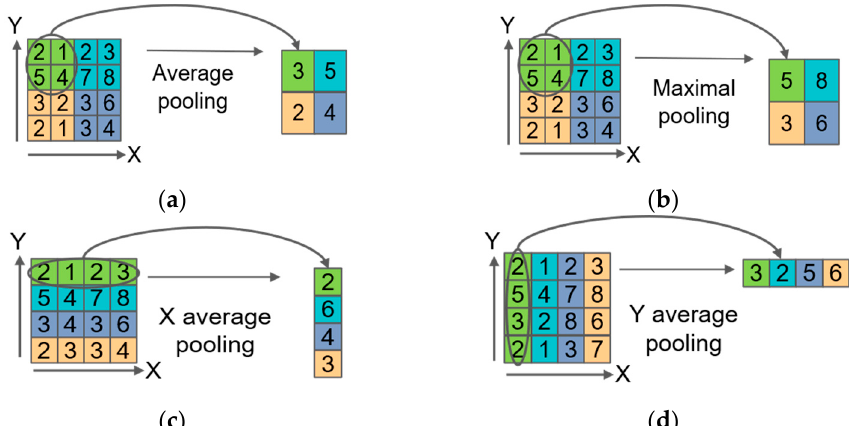
Figure 5. Four typical pooling operations: ( a ) Average pooling; ( b ) Maximal pooling; ( c ) X average pooling: one-dimensional features are encoded along the horizontal direction and then aggregated along the vertical direction; ( d ) Y average pooling: one-dimensional features are encoded along the vertical direction and then aggregated along the horizontal direction.